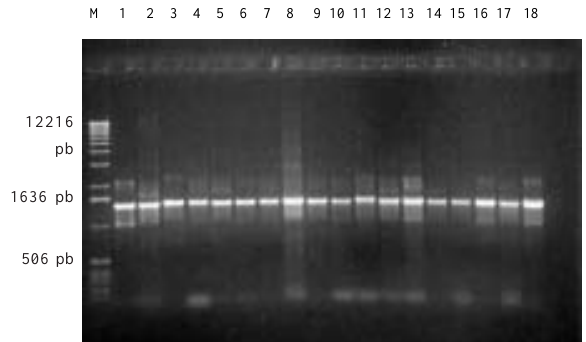
Figura 1. Produtos de amplificação da região 16S DNAr de estirpes de referência de diferentes diazotróficos e novos isolados de Azospirillum amazonense provenientes de três espécies de Brachiaria . M (marcador 1Kb Ladder), 1 (Y2),